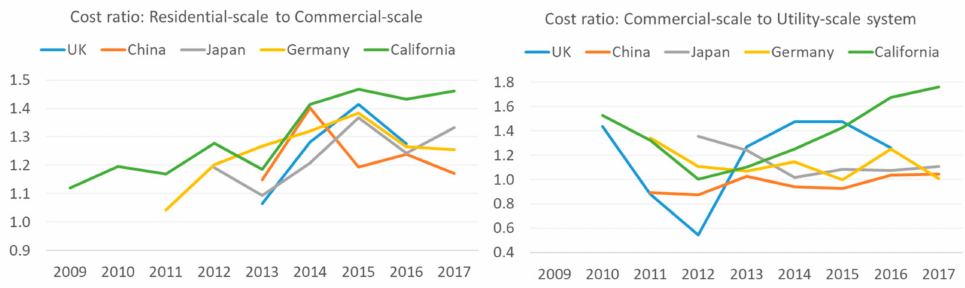
Figure 6. Comparisons of the cost of a utility-scale solar system, a commercial-scale system (a few hundred kW) and a residential-scale system in different regions (authors’ analysis based on IRENA’s renewable energy cost database)